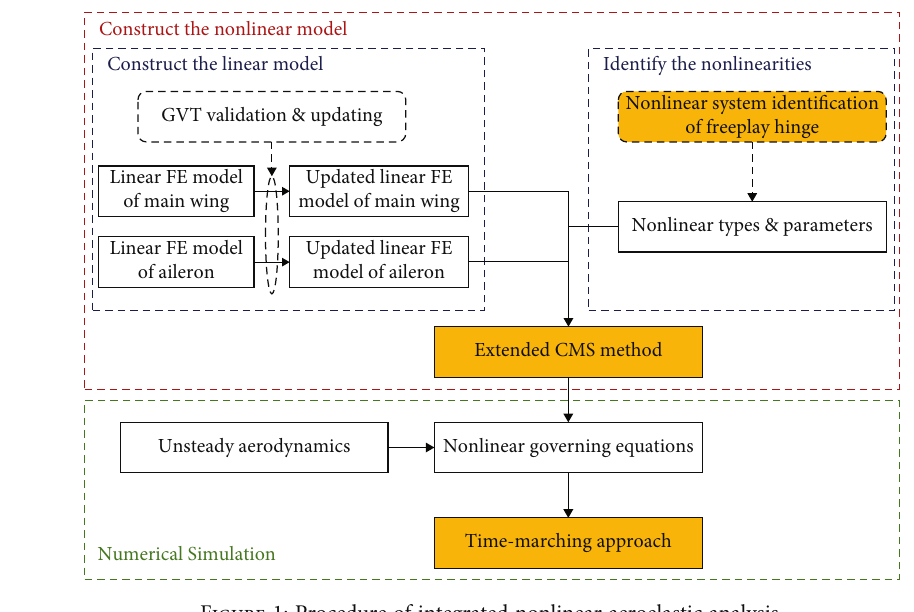
Figure 1: Procedure of integrated nonlinear aeroelastic analysis.